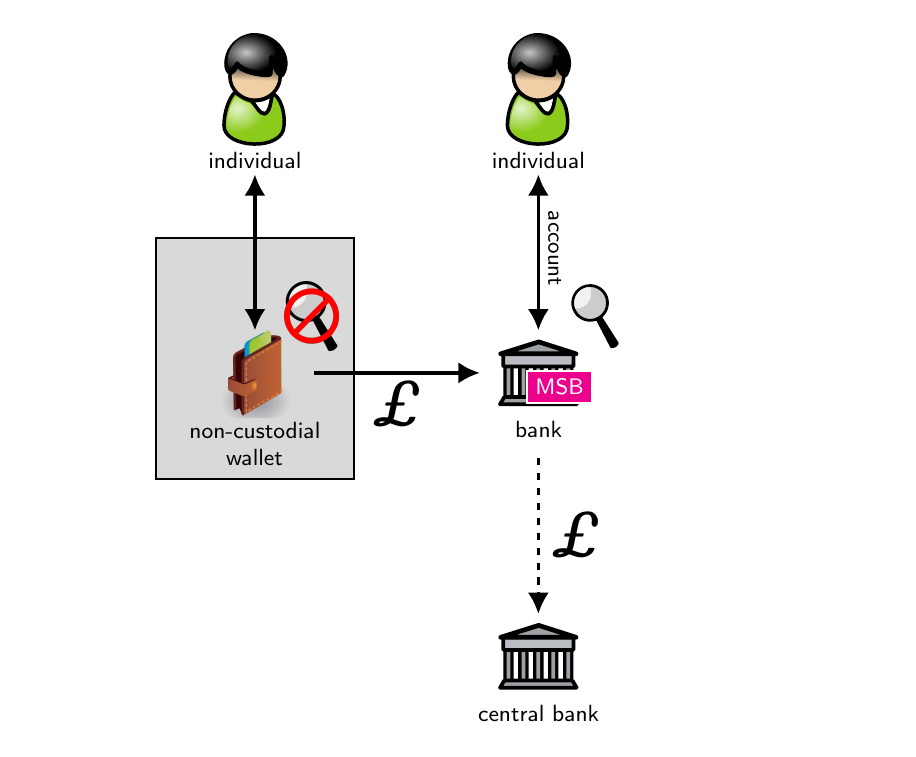
Figure 4. Schematic representation of a user depositing CBDC into a bank account.